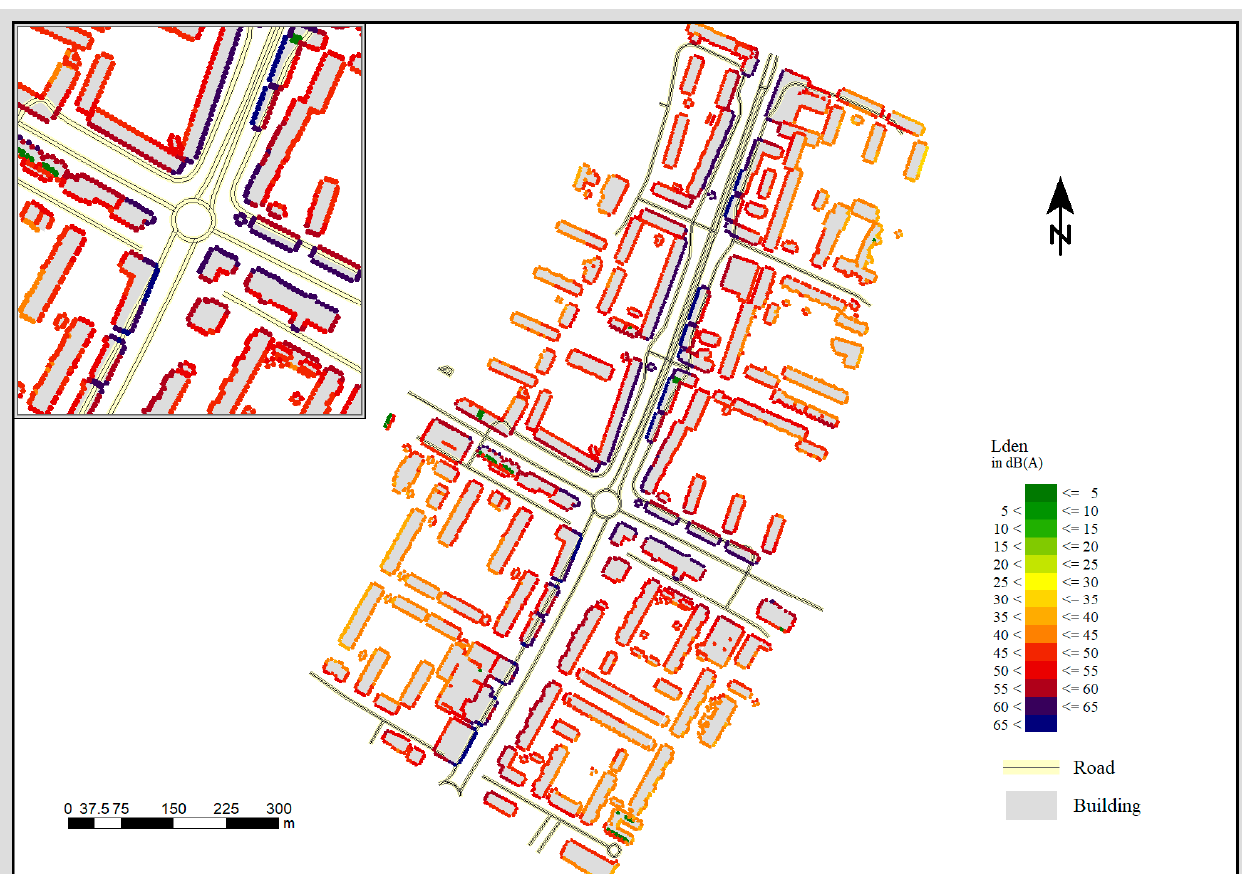
Figure 17. Result of noise simulations in the Lorensborg–Bellevue area in Malmö. The simulations were performed in SoundPlan in accordance with the CNOSSOS-EU model. Lden is a descriptor of noise level over a whole day, with a penalty of 5 dB(A) for evening noise (19.00–23.00) and a penalty of 10 dB(A) for night-time noise (23.00–7.00). It should be noted that this simulation was performed with some planned buildings included; therefore, there is some overlap between current roads and building objects.